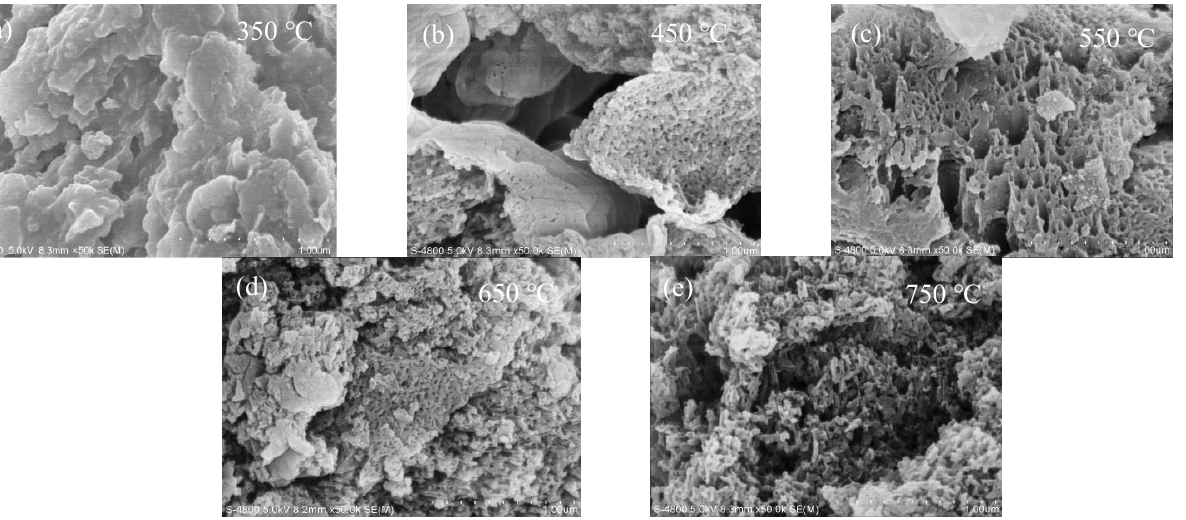
Figure 1. SEM of B-TiO 2 /C 3 N 4 under different calcination conditions: ( a ) 350 °C; ( b ) 450 °C; ( c ) 550 °C; ( d ) 650 °C; ( e ) 750 °C.